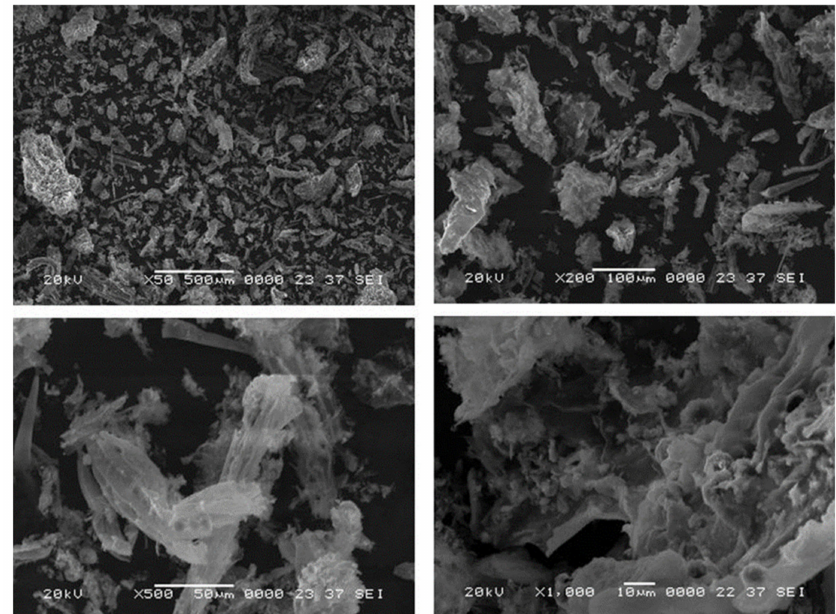
Figure 4. SEM images of sheep dung ash at different